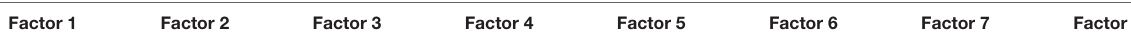
TABLE 4 | Standardized factor loadings for the